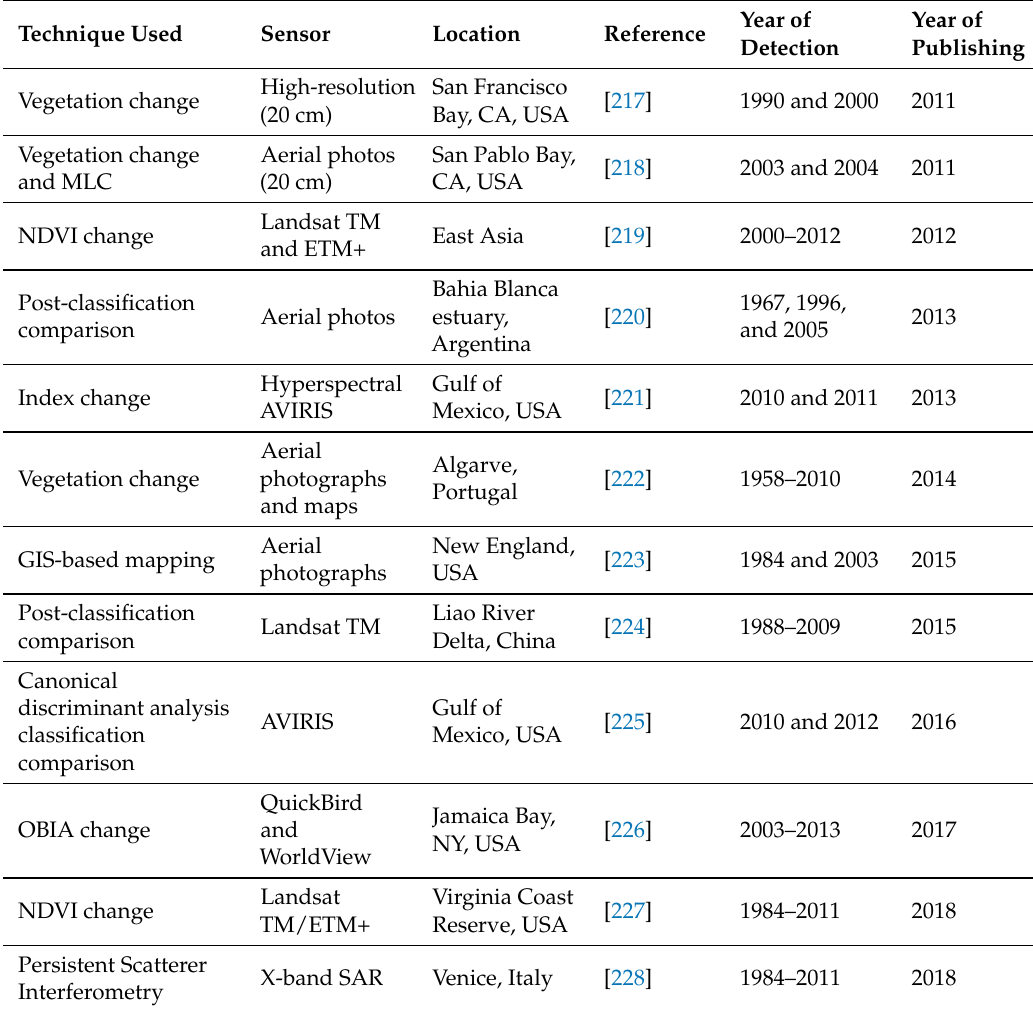
Table 7. Change detection and monitoring techniques of salt marshes using remote sensing